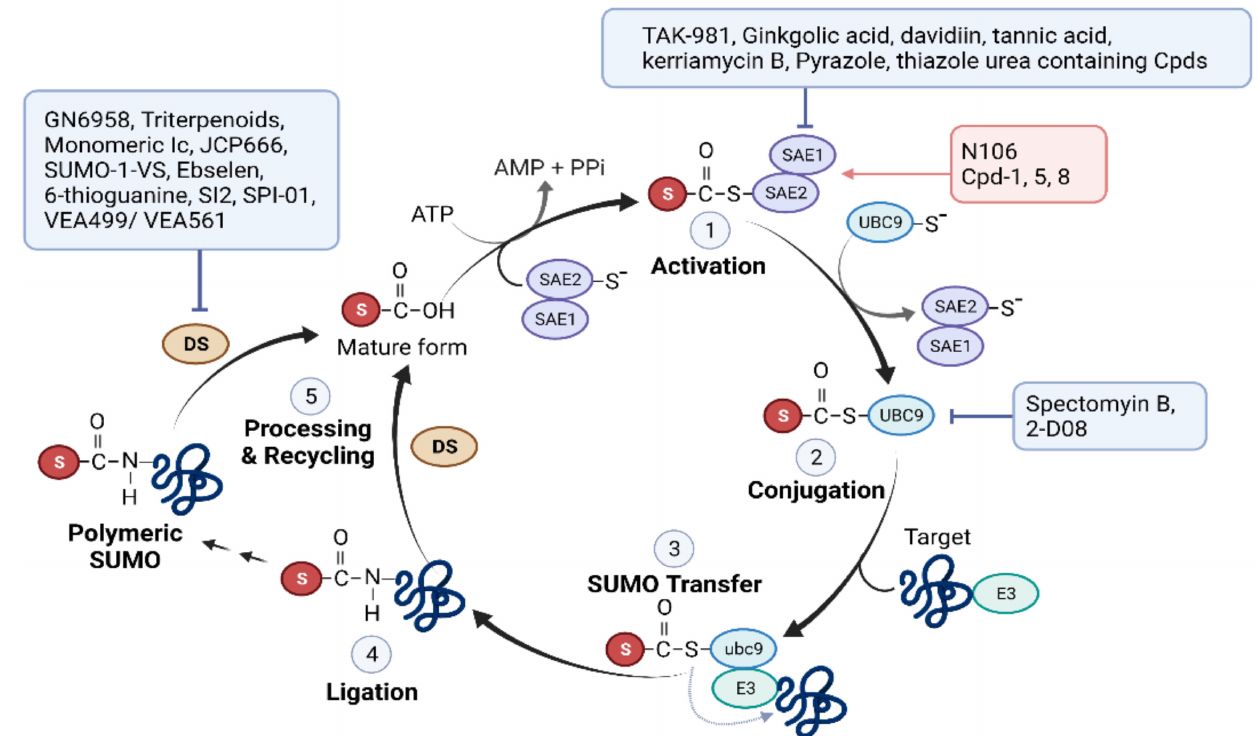
Figure 3. Small molecules targeting the SUMO pathway. In step 1: SUMO E1 (SAE1/SAE2 het- erodimer) activates mature SUMO through an ATP-dependent reaction. SAE1 catalyzes adenylation of the C-terminus of SUMO to form a SUMO-AMP intermediate, which then transfers SUMO to SAE2 and forms a thioester bond. In step 2: SUMO is transferred from SAE2 to SUMO E2 (UBC9), which in turn forms a thioester bond. In steps 3 and 4: UBC9 catalyzes the formation of an isopeptide bond between the C-terminal glycine of SUMO and a lysine residue on the substrate. Certain SUMO E3 ligases are often involved in this process. In step 5: SUMO is removed from the lysine residue of the target proteins by a de-SUMOylation enzyme (DS), such as SENP, sentrin-specific protease. SENP also catalyzes SUMO maturation by cleaving the precursor SUMO at C-terminus, exposing two glycine residues required for